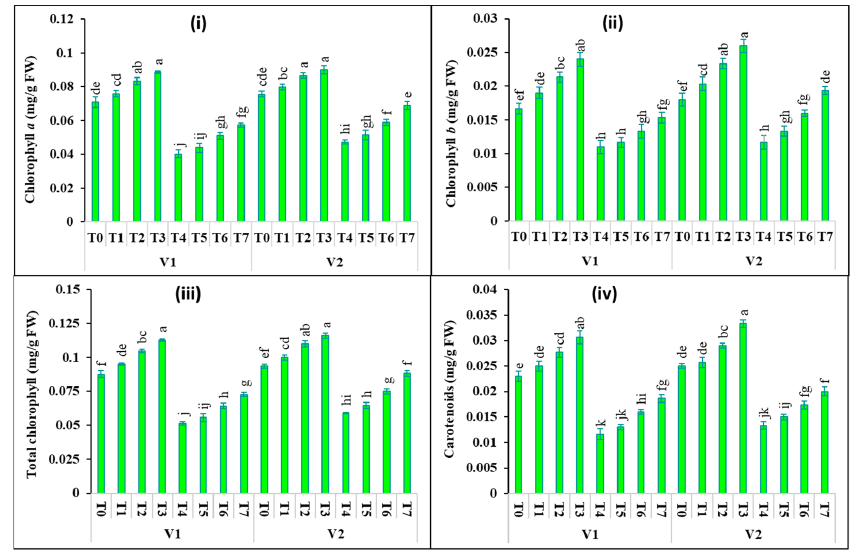
Figure 2. Influence of salicylic acid priming on ( i ) chlorophyll a , ( ii ) chlorophyll b , ( iii ) total Chloro- phyll, and ( iv ) carotenoids weight under salt stress; T0 (control), T1 (hydropriming), T2 (10 mM SA priming), T3 (20 mM SA), T4 (170 mM NaCl), T5 (170 mM NaCl + hydropriming), T6 (170 mM NaCl + 10 mM SA priming), and T7 (170 mM NaCl + 20 mM SA priming); bars sharing same case letter or without lettering, for a parameter, do not significantly differ ( p ≤ 0.05) by the LSD test.